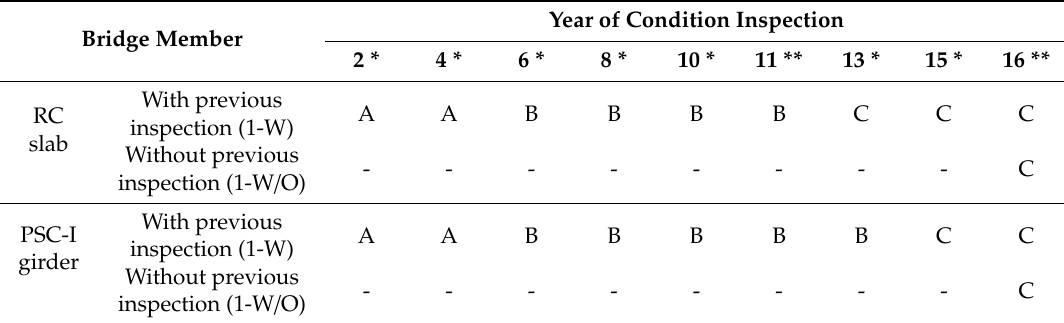
Figure 4. Example of a calibrated performance degradation model. Table 6. Condition level of an RC slab and PSC-I girder (inspection type 1).